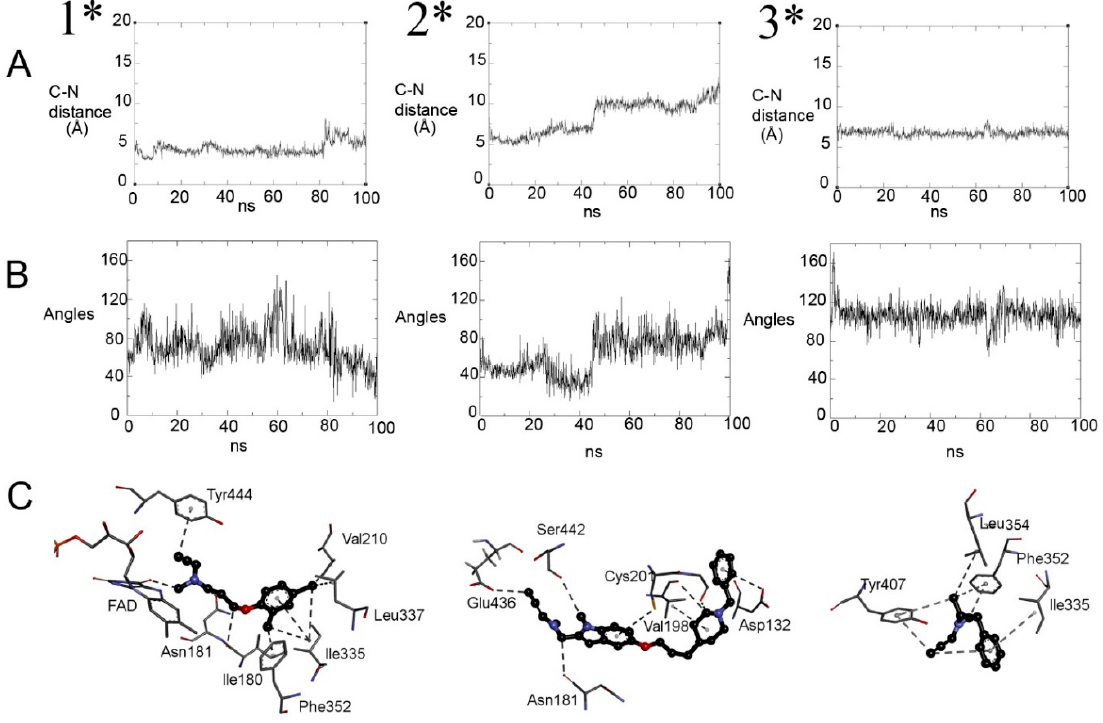
Figure 9. Orientation and movement of allenyl products in the active site of MAO-A. ( A ) Atom plot distances for the imine C-terminal to N5-FADH − . ( B ) Angle N5 to C = C = C. ( C ) interactions between allenyl products and reduced MAO-A. Columns from left to right, the compounds are: left : oxidized product from clorgyline (1*); middle : oxidized product from ASS234 (2*); right : oxidized product from selegiline (3*).